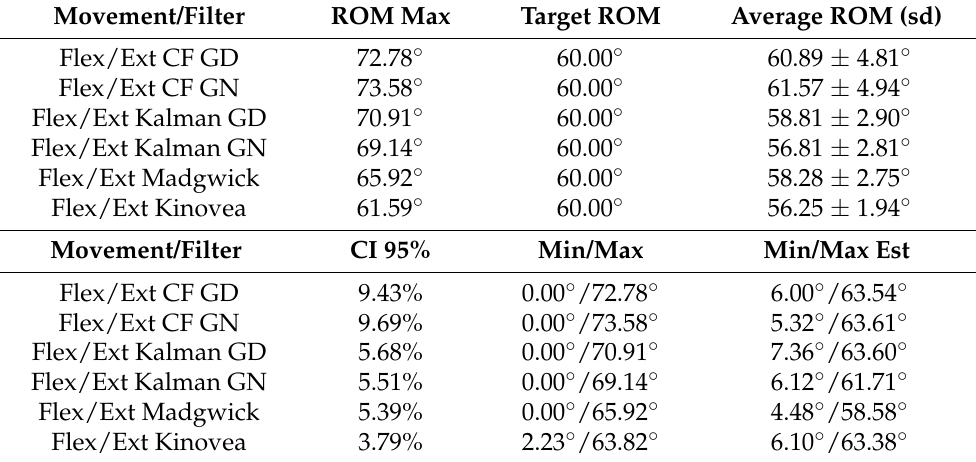
Table 2. Experiment 1—Metrics.